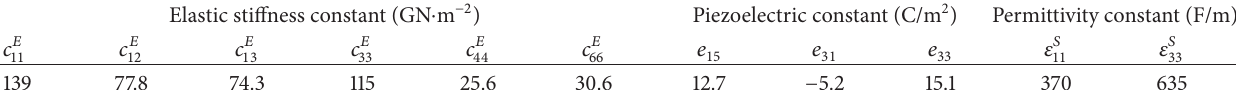
Table 3: Material parameters of the PZT-4 ceramics.